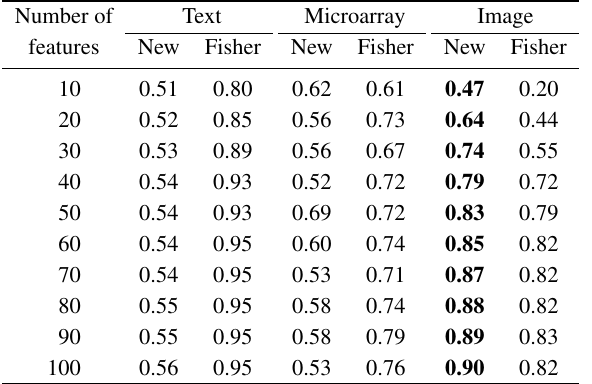
Table 2 Comparison of accuracies on heterogeneous